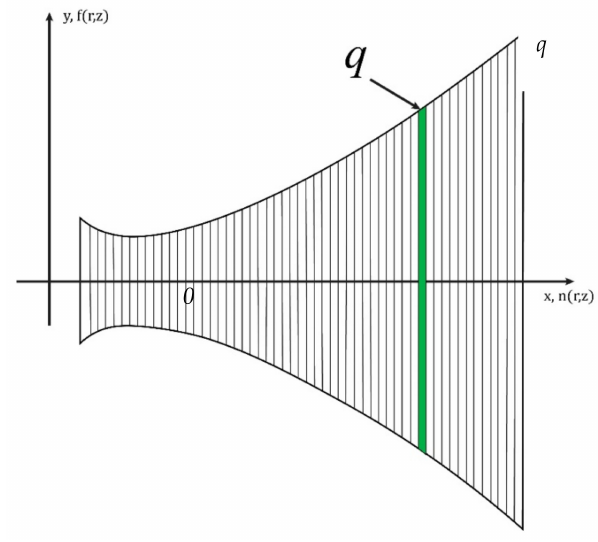
Figure 3. Illustration of the principle of splitting the focon into short layers, q ∈ [1, Q ], Q is total number of layers, z = ∆ z · q